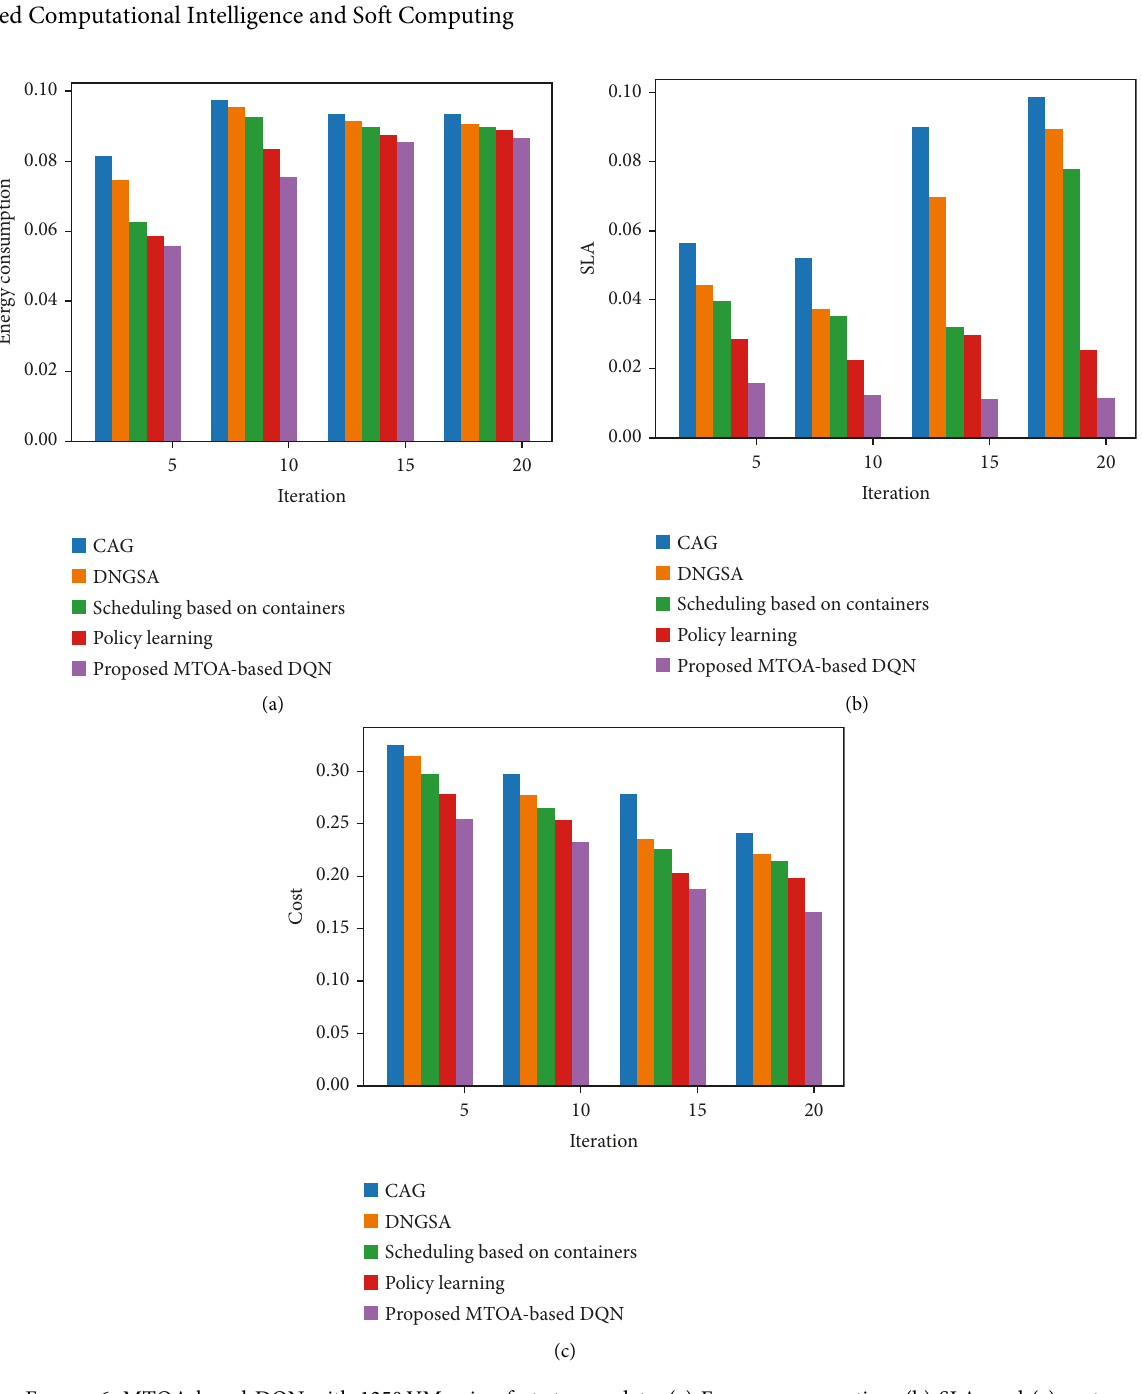
Figure 6: MTOA-based DQN with 1250VM using fast storage data. (a) Energy consumption, (b) SLA, and (c)